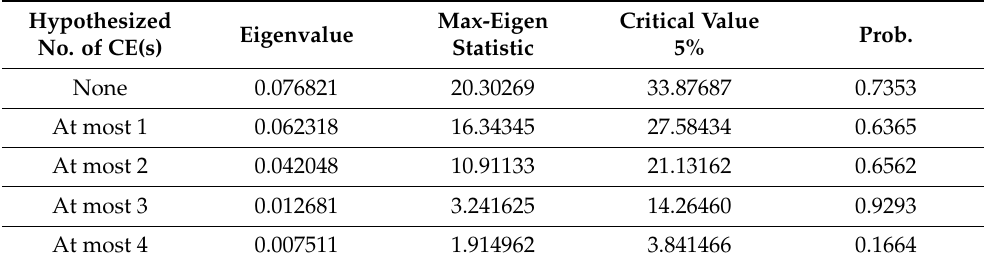
Table 4. Trace statistic—Johansen cointegration method (pre ‐ COVID ‐ 19 period). Table 5. Max eigenvalue—Johansen cointegration method (pre-COVID-19 period). Hypothesized Hypothesized No. of